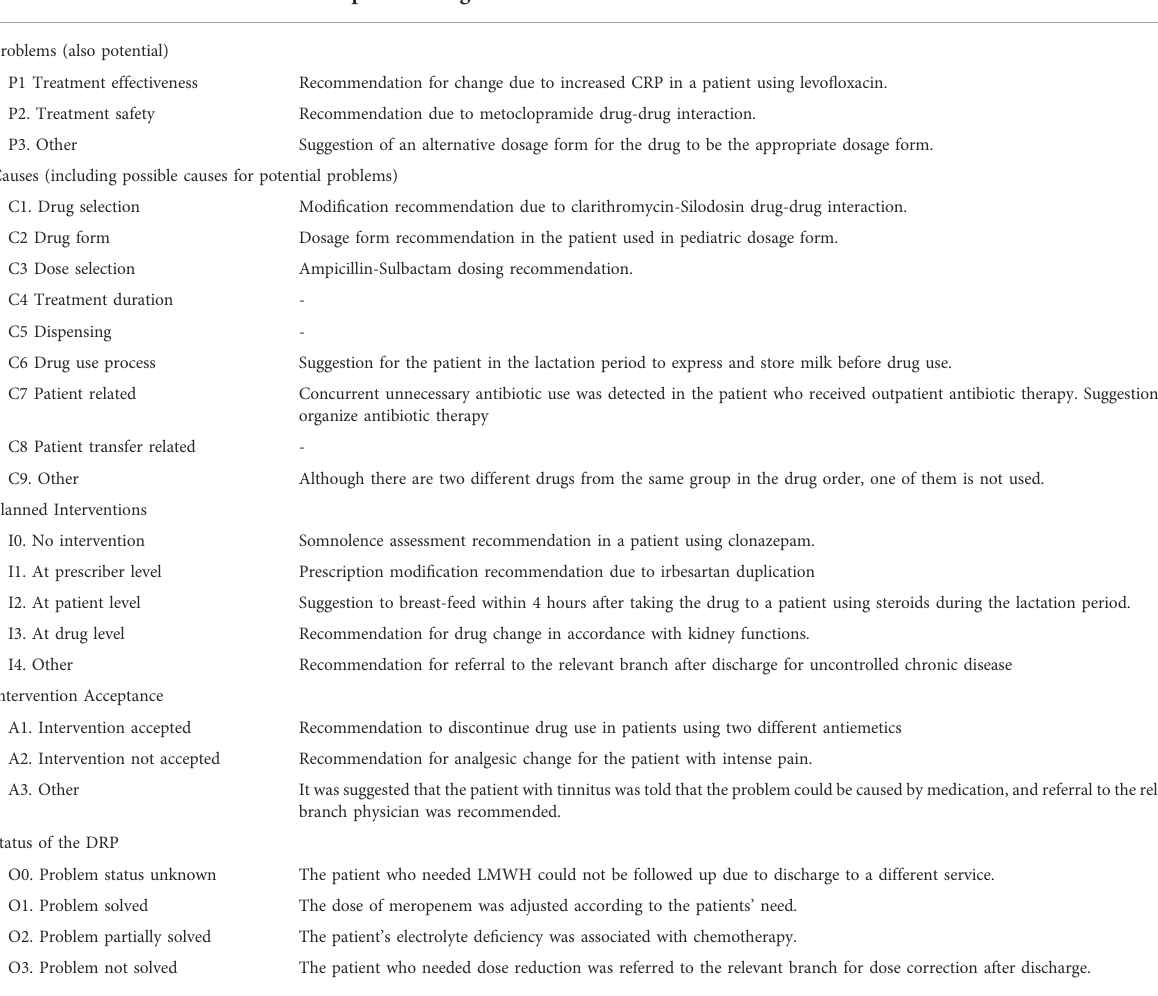
TABLE 5 Examples of drug-related problems identi fi ed in the control and intervention groups and recommended by the